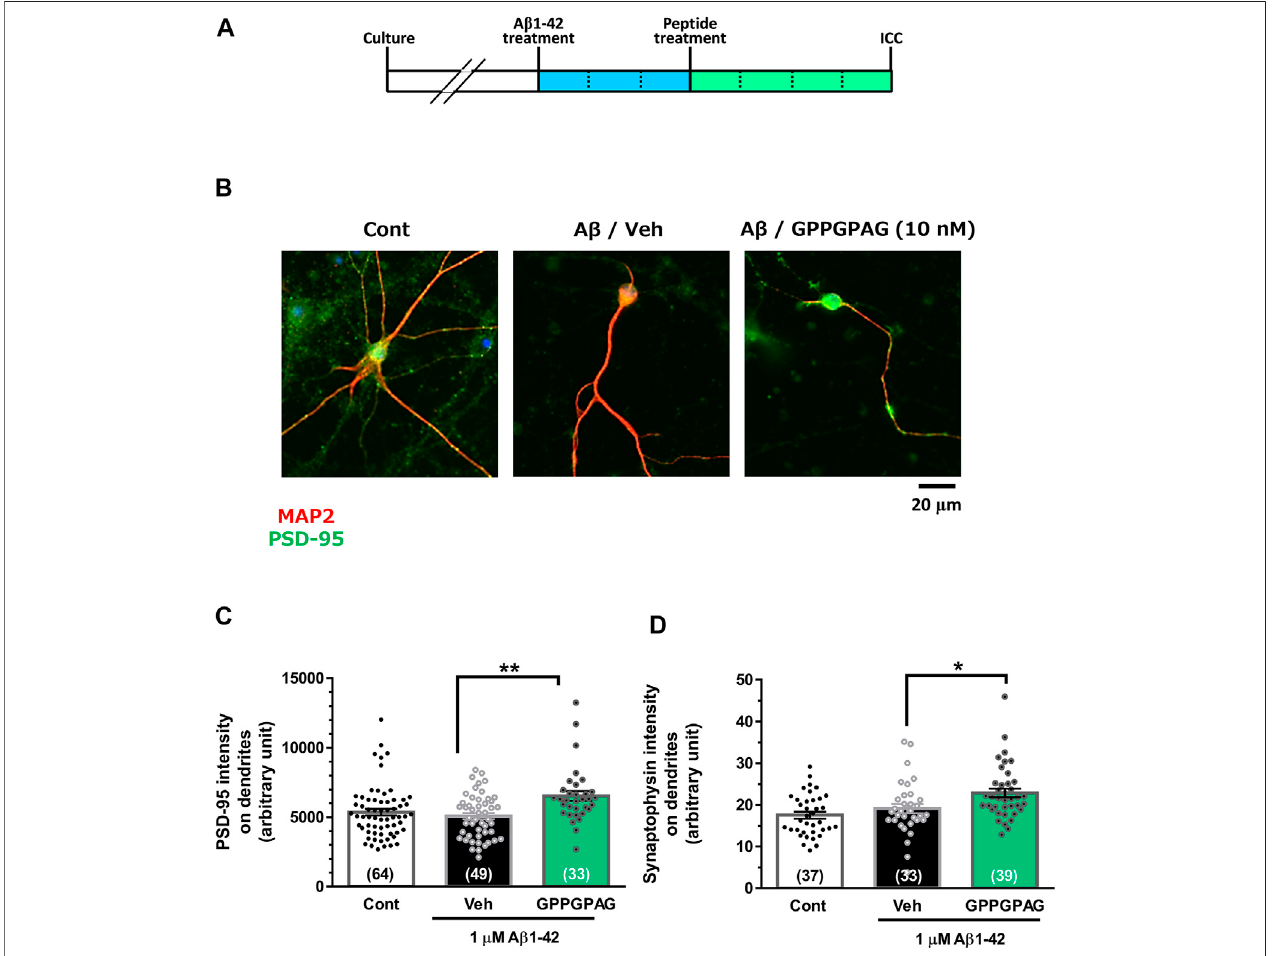
FIGURE2| EffectofGPPGPAGonpost-synapticandpre-synapticintensitiesunderA β treatment. (A) Corticalneuronswereculturedfor21 daysandthentreated withorwithoutaggregatedA β 1-42(1 μ M).ThreedaysaftertheadministrationofA β 1-42,thecellsweretreatedwithGPPGPAGoravehiclesolution(Veh;distilledwater). After an additional 4-days of treatment, the cells were fi xed and double-immunostained for MAP2 and PSD-95 or MAP2 and synaptophysin. (B) Representative photos ofthePSD-95-positivepresynapticvesicles(green)onMAP2-positivedendriticshafts(red)areshown.Scalebarindicates20 μ m. (C) ThePSD-95-positivepuncta intensity was quanti fi ed for each dendrite. ** p < 0.01, one-way ANOVA with post hoc Bonferroni ’ s test, n (cid:2) 33 – 64 (D) The synaptophysin-positive puncta intensity was quanti fi ed for each dendrite. * p < 0.05, one-way ANOVA with post hoc Bonferroni ’ s test, n (cid:2) 33 – 39. mean ± standard error. Each number of samples is shown in